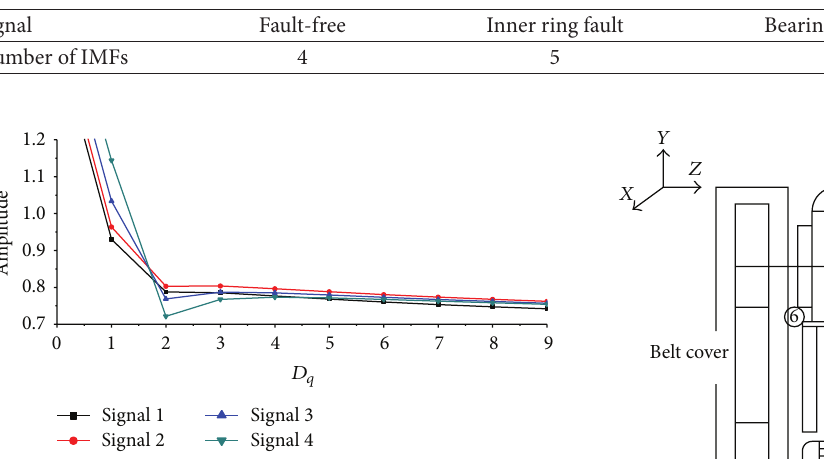
Figure 13: The generalized dimension curve of exceeding higher limit 𝐽 .